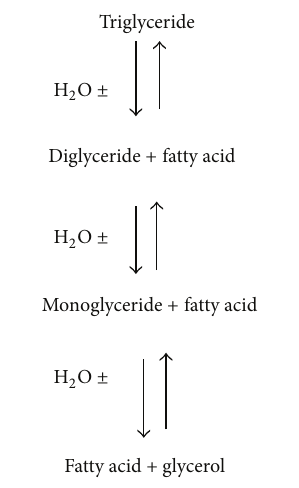
Figure 2: The mediated lipase